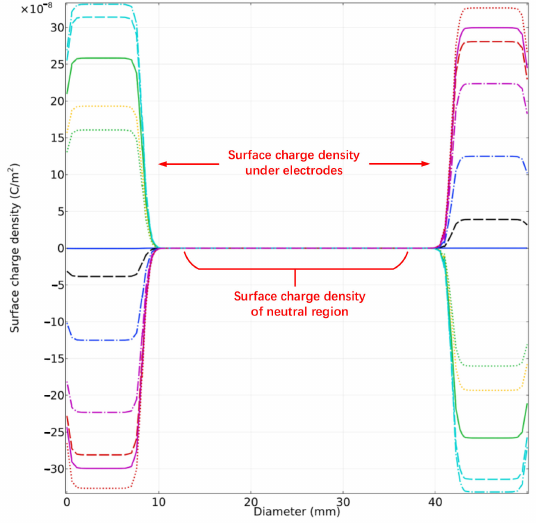
Figure 13. Distribution of surface charge density on whole surface under AC actuation. The curve indicates the distribution at discrete time